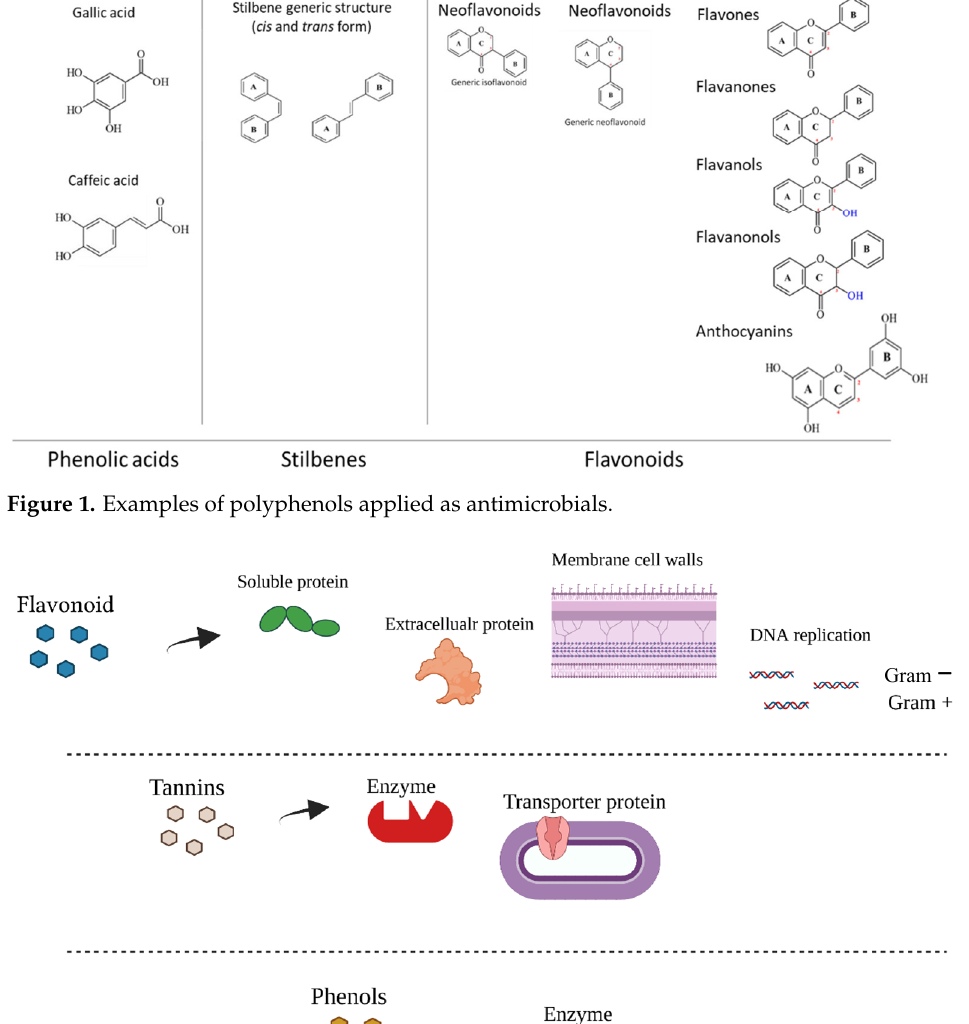
Figure 2. Flavonoid, tannin and phenol antimicrobial mechanisms of action.